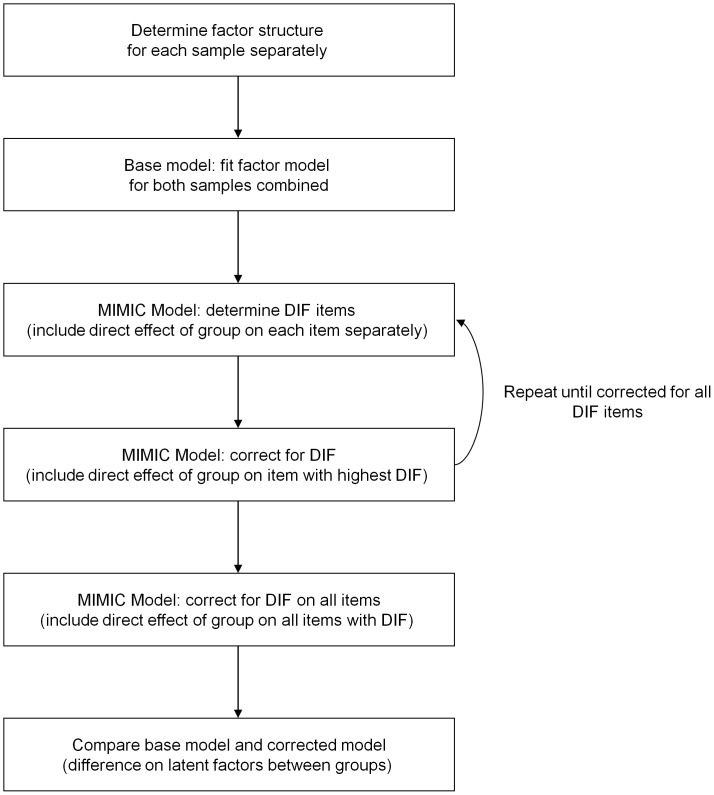
Flowchart of steps to be undertaken in DIF analysis.